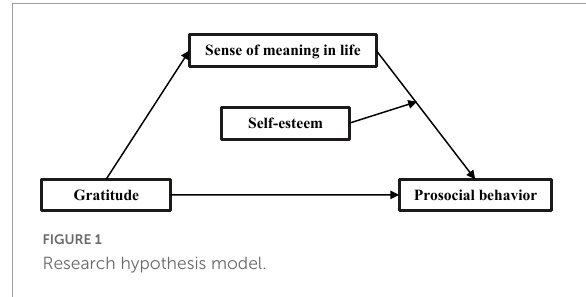
FIGURE1 Research hypothesis